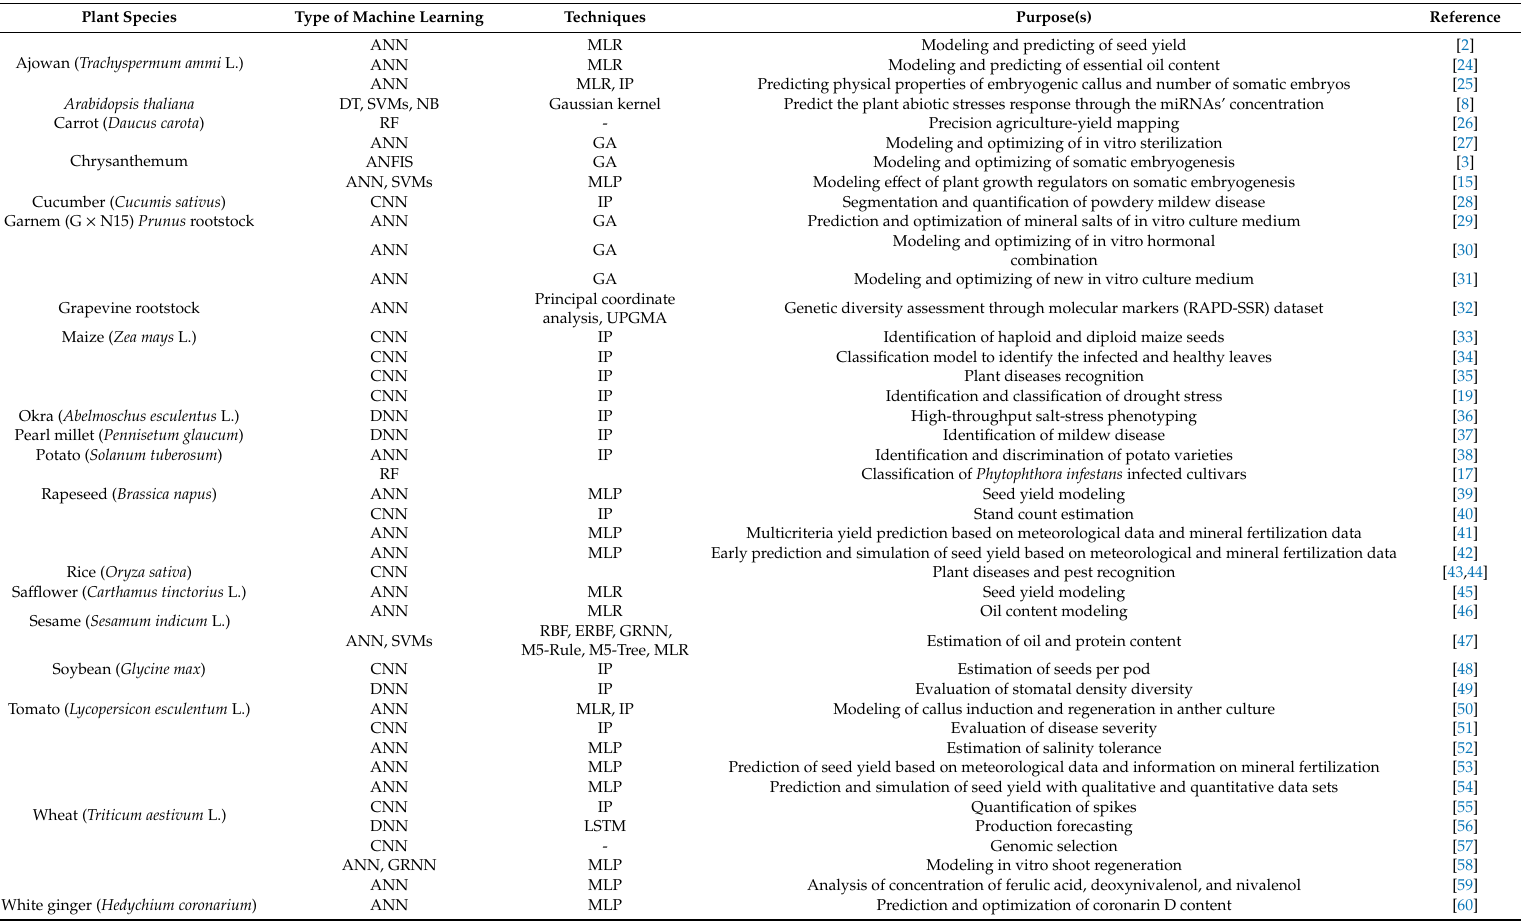
Table 2. Examples of recently applied nonlinear machine learning models in classical and modern plant breeding studies.